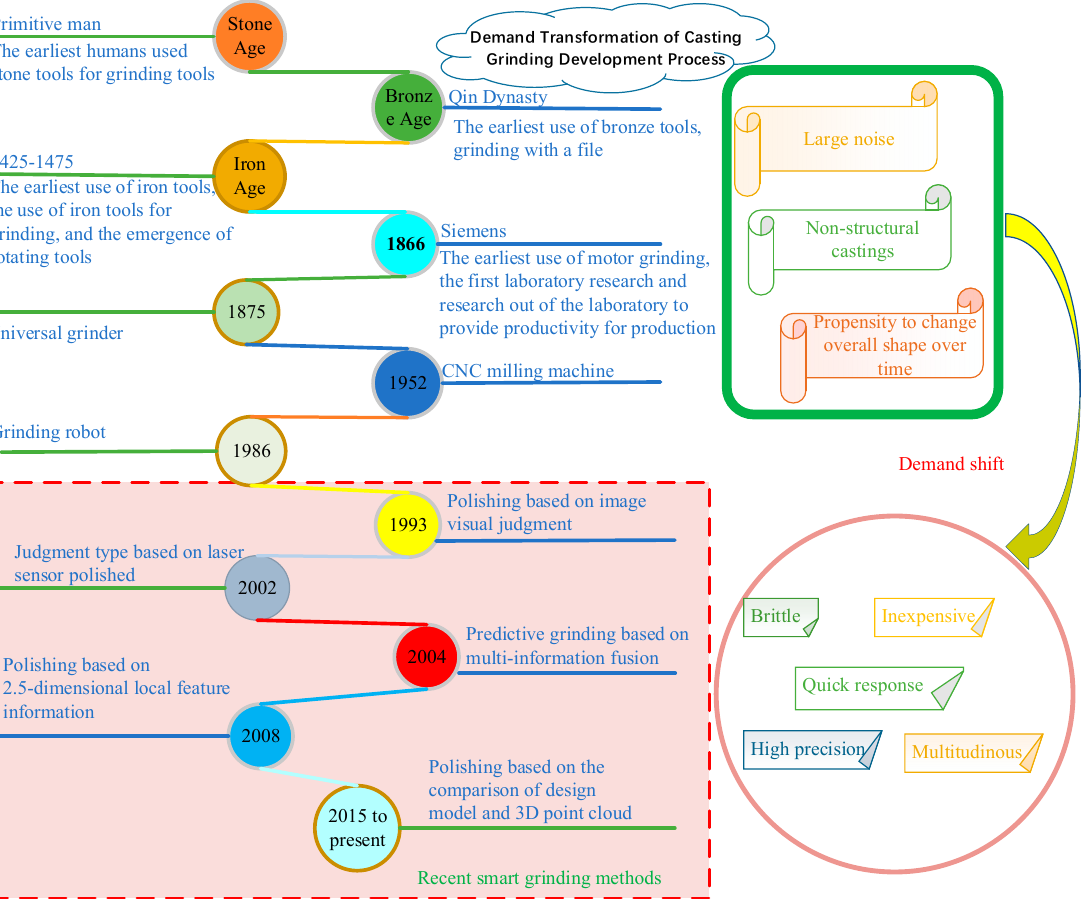
Figure 19. Demand conversion and grinding process development.